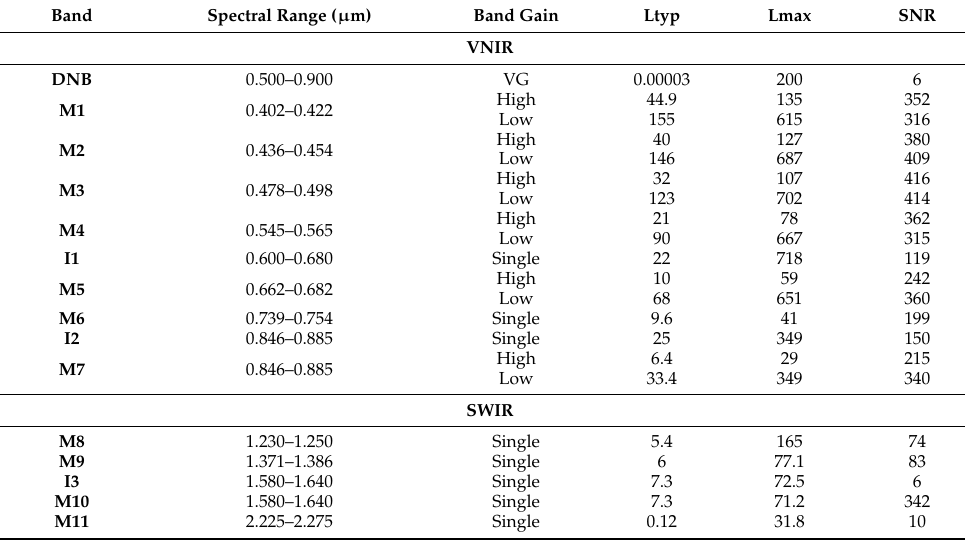
Table 1. VIIRS spectral, dynamic range and noise requirements for the reflective solar